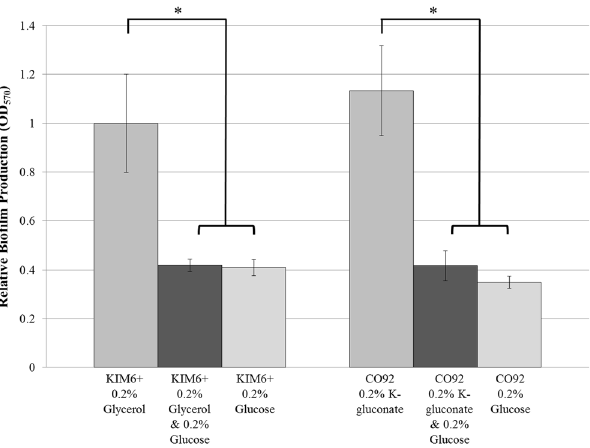
Fig 3. Carbon Catabolite Regulation of Y . pestis Biofilm Production. Crystal violet biofilm quantification assay of KIM6+ and CO92 when cultured in BCS medium supplemented with primary (glucose) and/or alternate (glycerol or K-gluconate) carbon sources. Error bars reflect standard deviation from the mean derived from two independent experiments, each consisting of 6 technical replicates. * P-value < 0.005 determined by Tukey ’ s HSD post-hoc analysis.